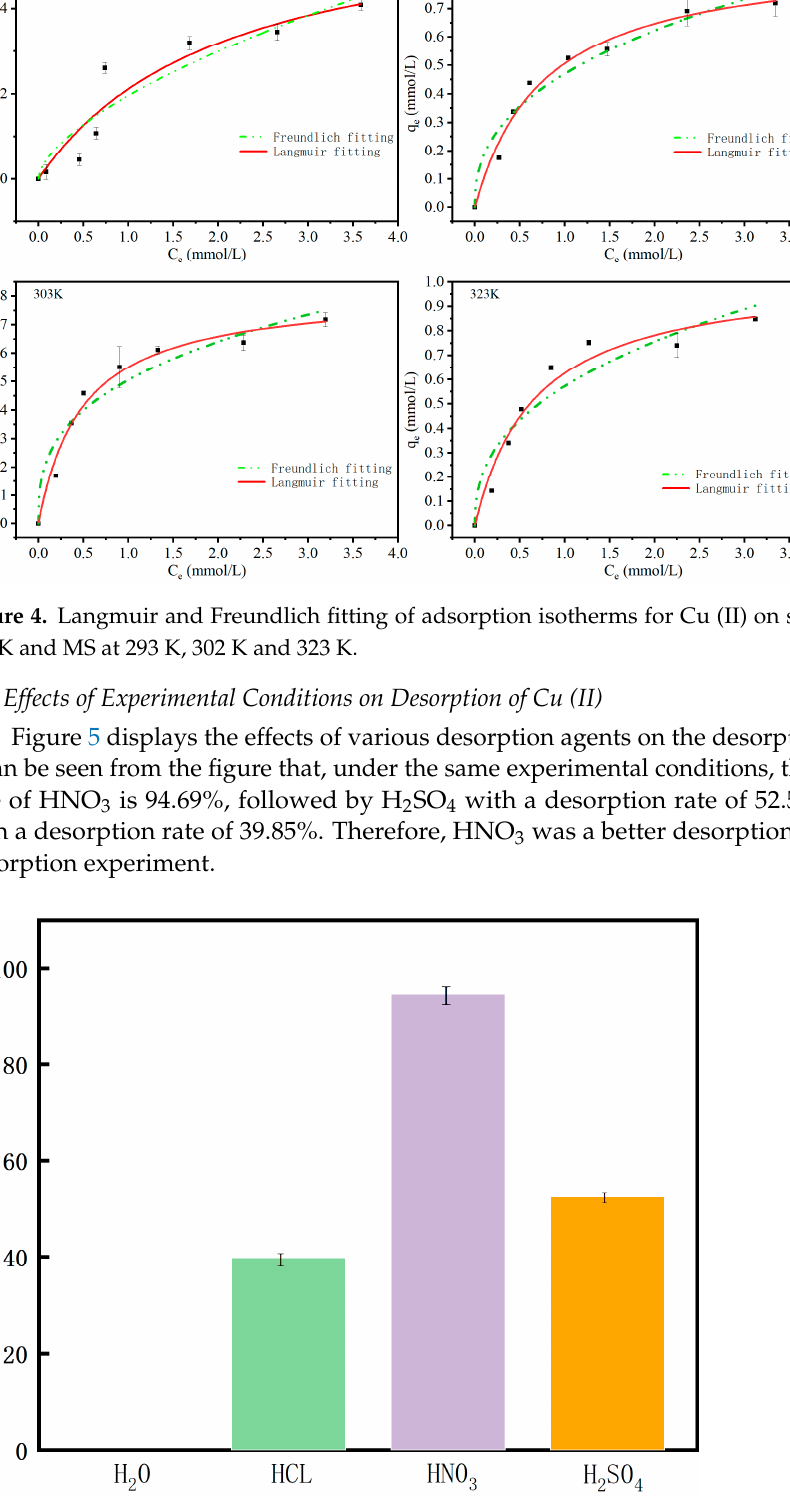
Figure 5. Influence of desorption solution types on Cu (II) desorption.